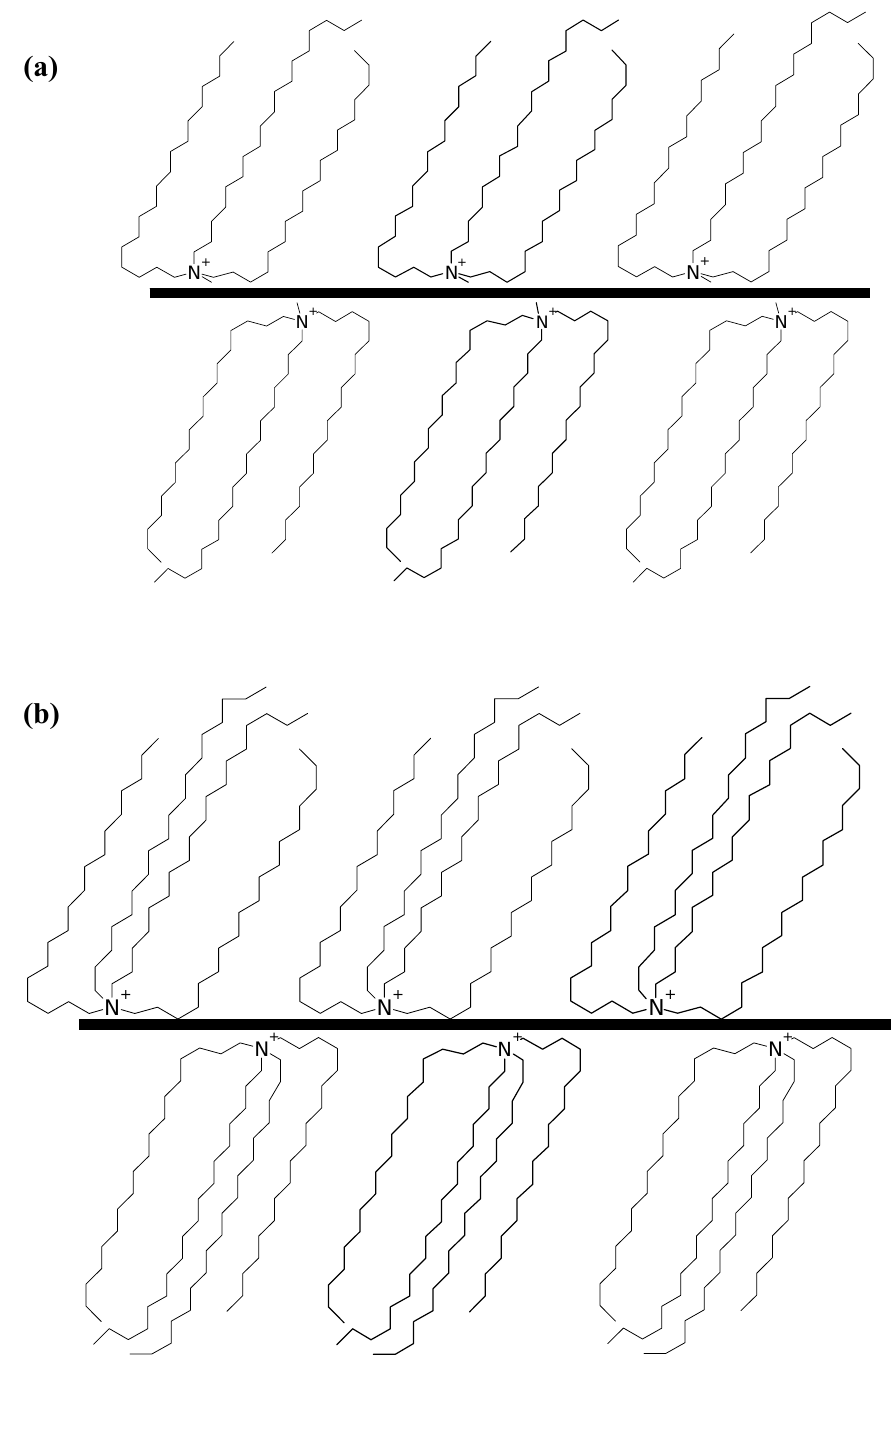
Figure 25. Filler platelets modified with (a) trioctadecylmethylammonium and (b) tetraoctadecylammonium. Reproduced from reference